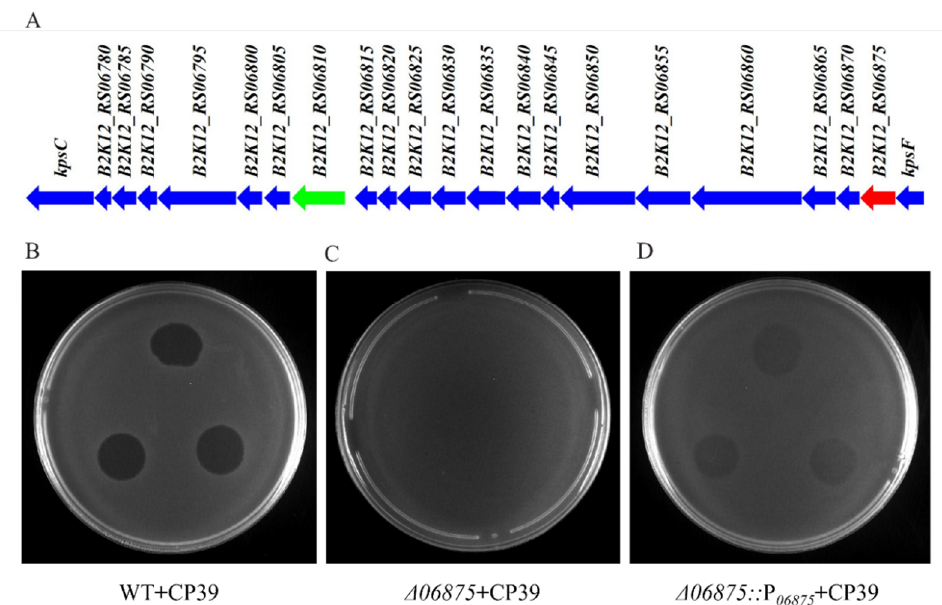
Figure 3. The 06875 gene in CPS loci is responsible for the CP39 resistance in C. jejuni NCTC12662. ( A ) Schematic diagram of CPS loci from C. jejuni NCTC12662. B2K12_RS 06810 (green arrow) en- codes the MeO P N-GalfNAc transferase, which the modification of MeO P N is known to be respon- sible for C. jejuni phage resistance. B2K12_RS 06875 (red arrow) is annotated as CDP-glycerol- glycerophosphate glycerophosphotransferase, which related to the phage CP39 resistance in this study. The phage sensitivity assay confirmed the 06875 gene was responsible for infection of phage CP39, which wild type strain NCTC 12662 (WT) ( B ) ∆ 06875 mutant ( C ) and its complementary strain Δ 06875 ::P 06875 ( D ) was infected by CP39 on soft agar plate.